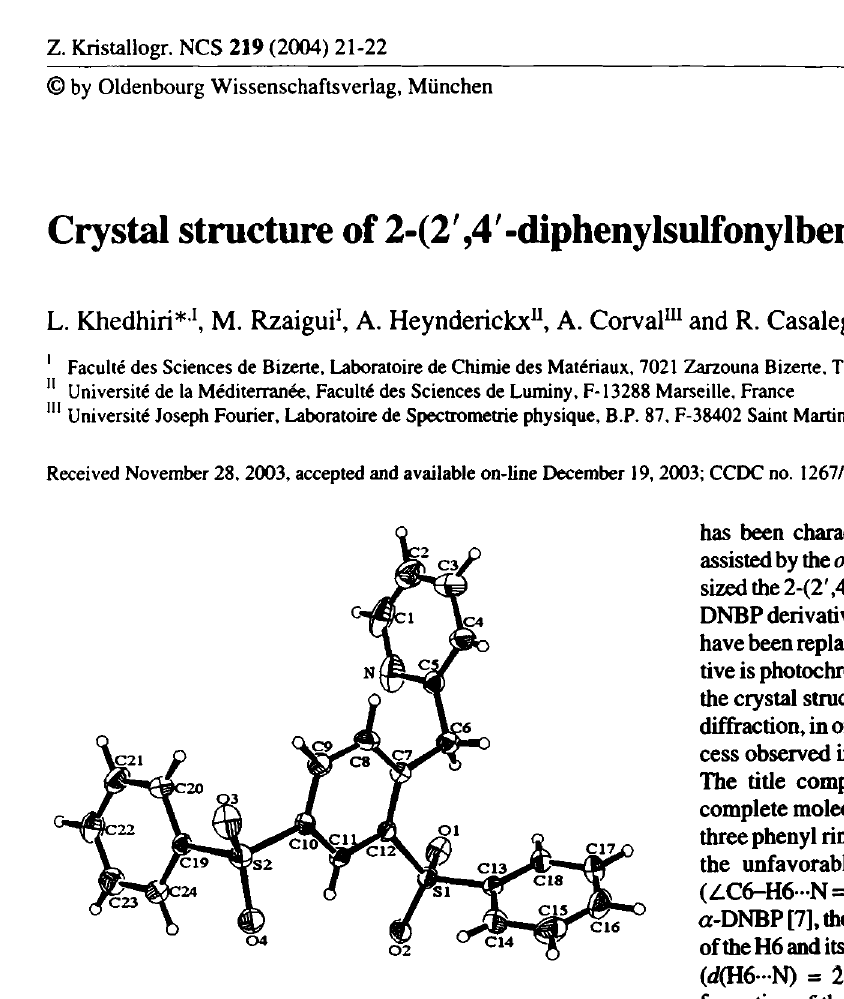
Table 1. Data collection and handling.